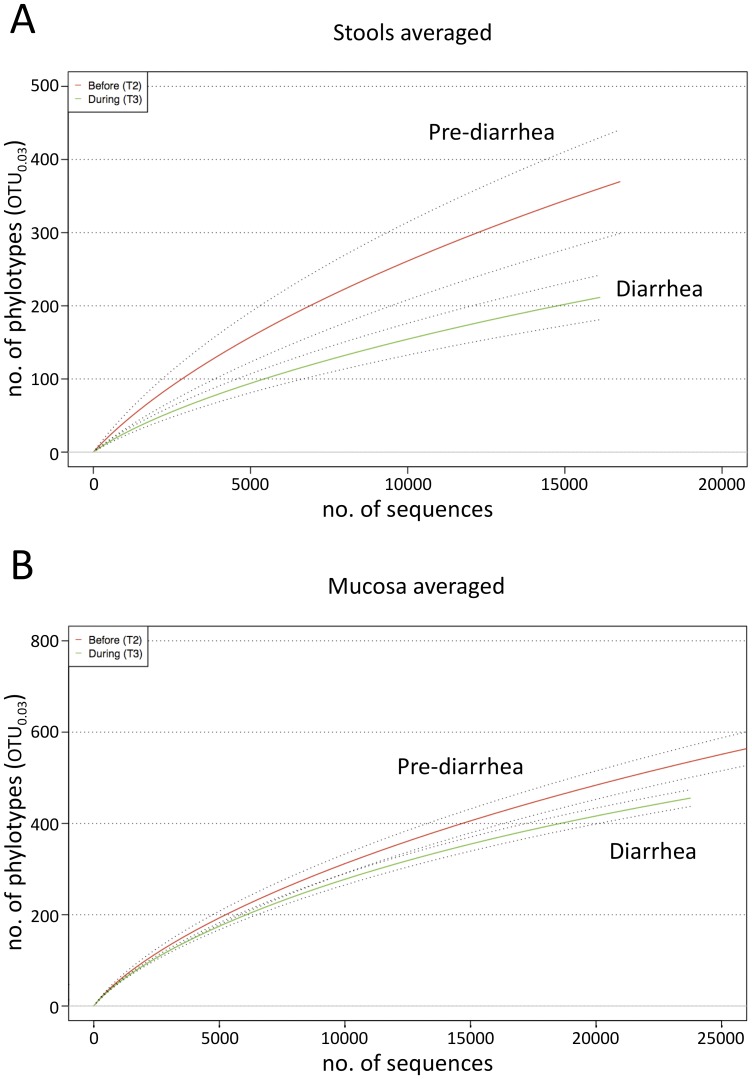
Osmotic diarrhea leads to decreased phylotype richness.(A) Rarefaction analysis of averaged stool samples before (time-point 2, red) and during diarrhea (time-point 3, green) shows significantly decreased richness (richness time-point 2 vs. time point 3: P = 0.029, Student’s t-test). (B) Rarefaction analysis of averaged mucosa samples before (time-point 2, red) and during diarrhea (time-point 3, green) shows a trend toward but non-significant decrease in richness (richness time-point 2 vs. time point 3: P = 0.08 Student’s t-test). The dotted line indicates ± SEM; OTU distance = 0.03.